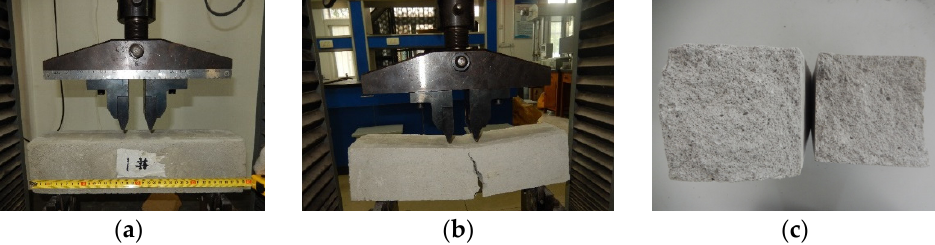
Figure 3. Quasi-static compression stress-strain curve of foamed concrete.